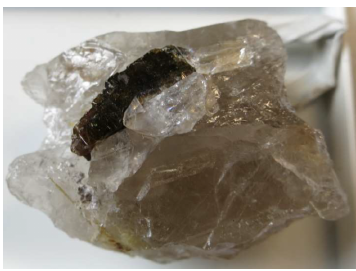
Figure 3. Xenotime embedded in quartz as an example for the REE-bearing mineral